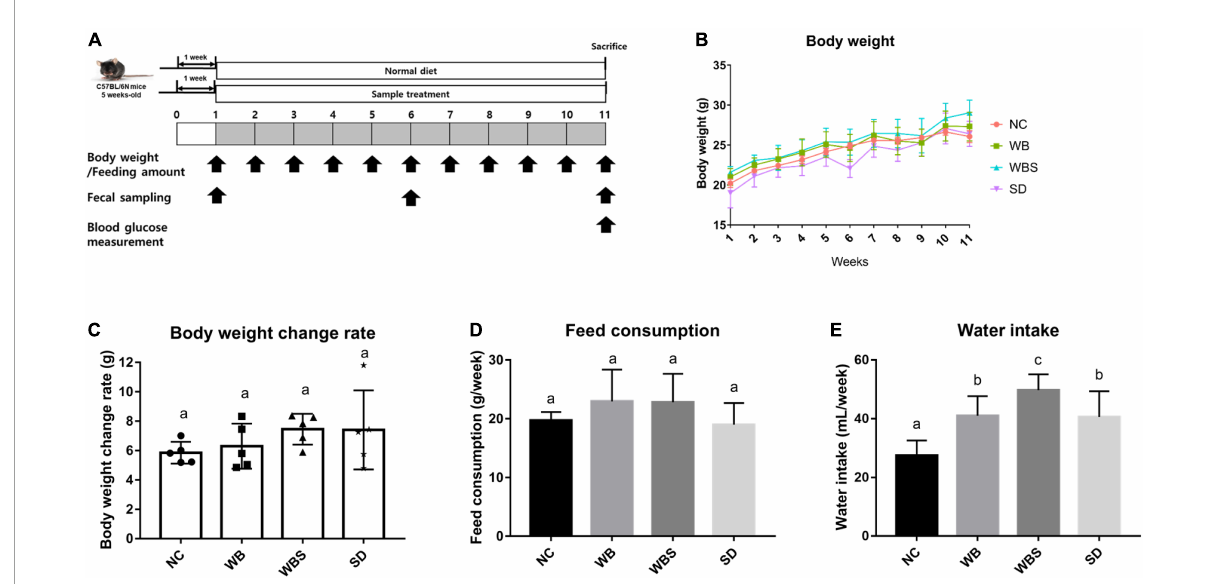
FIGURE1 (A) Overall experimental schedule of mouse feeding study with a one-week adaptation period and 10-week feeding period. Body weight and feeding amount were measured every week. Feeding samples were collected at weeks 1, 6, and 11. Blood glucose was measured at week 11. (B) Body weight measurement of the in vivo mouse models each week. NC: normal diet group as a negative control, WB: mouse feeding group with yeast-fermented white bread, WBS: mouse feeding group with 40% sourdough-supplemented white bread, SD: mouse feeding group with 100% unbaked sourdough. (C) Body weight change ratio for weeks 1–11 in each group. (D) Average of feed consumption amount every week in each group. (E) Average of water intake every week in each group. Error bars present the standard deviations of five replicates ( n = 5 male mice) in each group. One-way ANOVA followed by Duncan’s post-hoc analysis, and bars with different letters indicate significant differences at p <